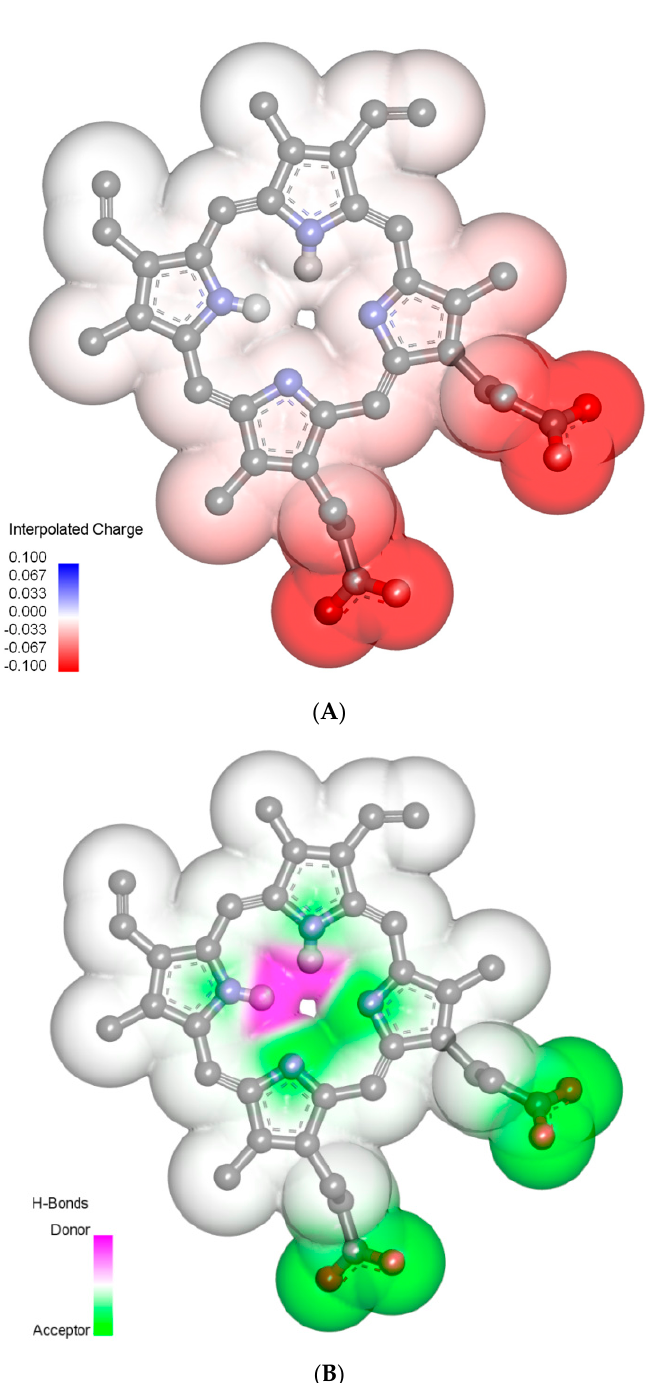
Figure 7. Three-dimensional structure of the PpIX molecule in the energy optimized conformation used in molecular docking. ( A ) Interpolated charges; ( B ) hydrogen bond donors and acceptors. Models are shown in the ball and stick representation with the van der Waals surface (atom surfaces are scaled to 100% of the van der Waals radii). For the sake of clarity, only polar hydrogen atoms are displayed.